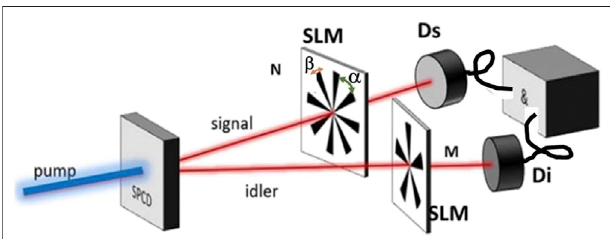
FIGURE 1 | Proposed experimental scheme for generation of high- dimensionalOAM-entangled photonpairs viaSPDC.Spatial Light Modulators (SLMs) containing ( N , M ) angular slits are placed in the path of signal and idler photons, generating high-dimensional angular qudits. Further details are in the text. The fi gure was modi fi ed from Ref.